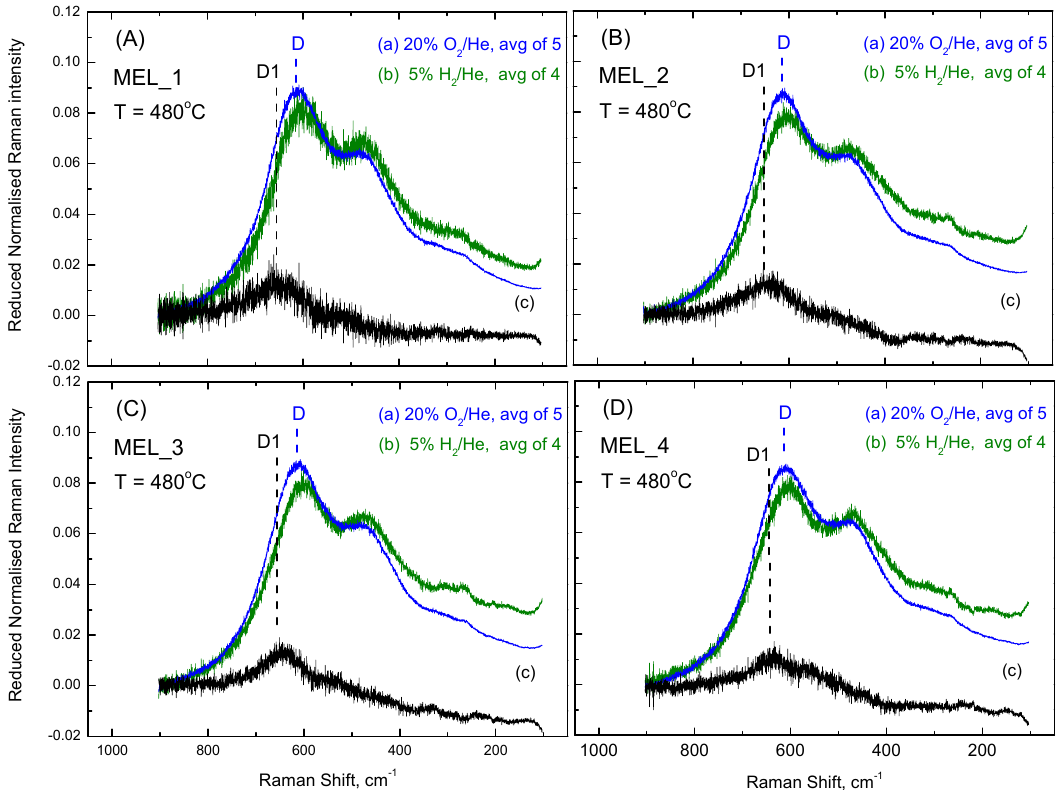
Figure 6. Sequential reduced and normalized in situ Raman spectra obtained at 480 ◦ C for ( A ) MEL_1; ( B ) MEL_2; ( C ) MEL_3; and ( D ) MEL_4. Traces (a) are the averages of five recordings under flowing 20% O 2 / He; traces (b) are the averages of four recordings under flowing 5% H 2 / He. Spectra under oxidizing and reducing gas atmosphere are recorded on alternate order. Traces (c) were obtained in each case after subtracting trace (b) obtained under H 2 gas from the corresponding trace (a) obtained under O 2 gas. Recording parameters, see Figure 1